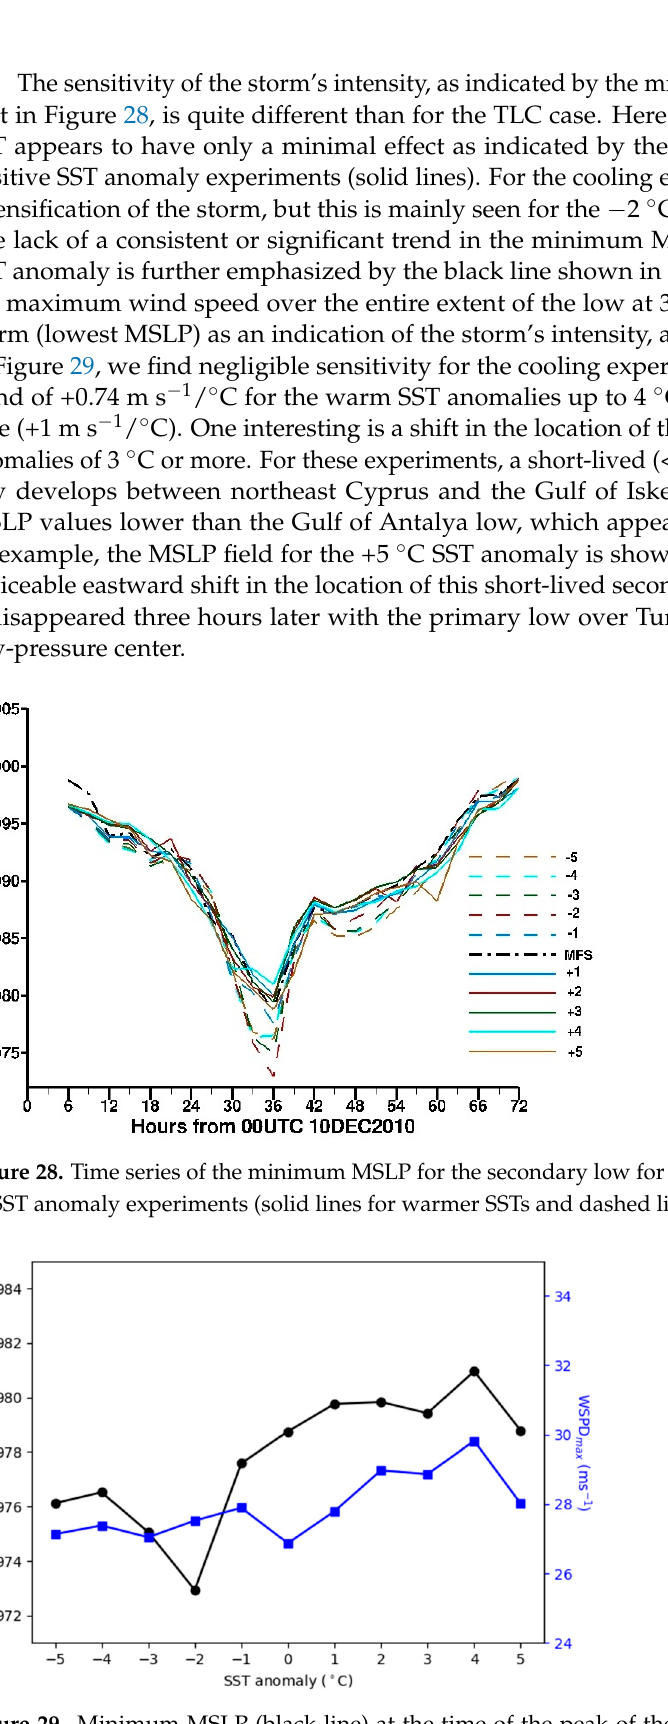
Figure 30. MSLP at 11 December 2010 09 UTC for the +5 °C SST anomaly run.